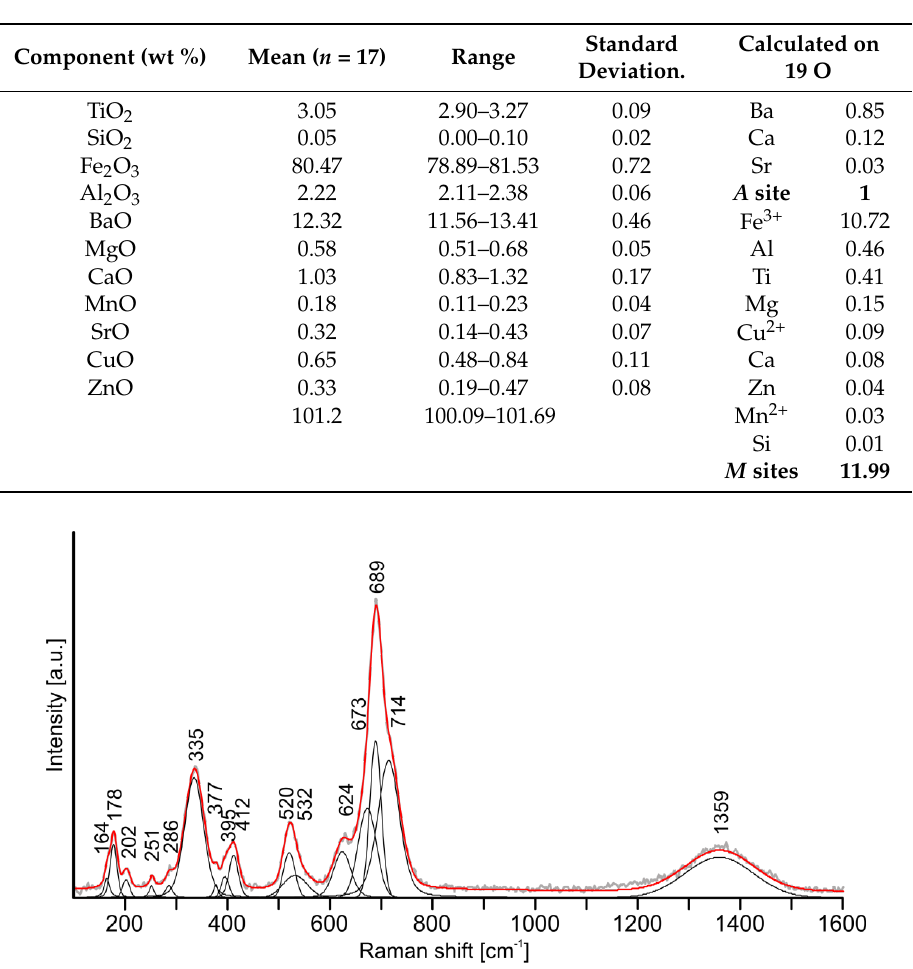
Table 2. Chemical composition of barioferrite from Har Parsa.